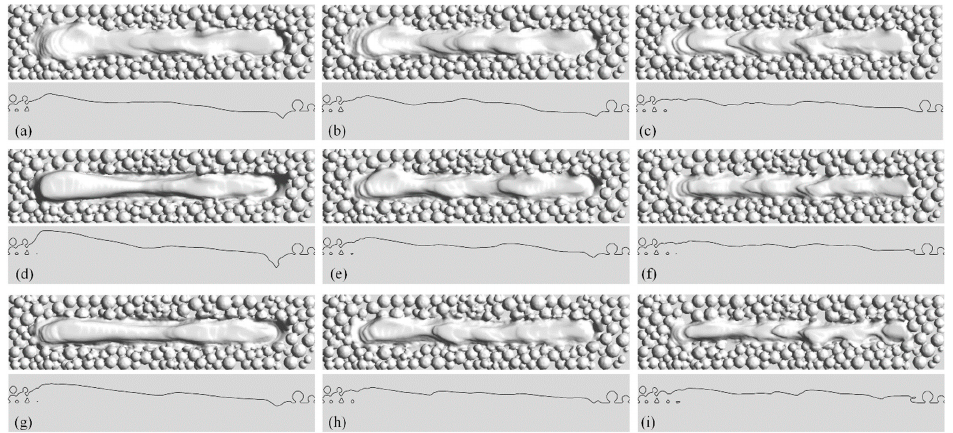
Figure 7. The morphology of the solidified track and the same on the longitudinal section under different laser powers and scanning speeds. ( a ) 200 W, 1 m/s; ( b ) 150 W, 1 m/s; ( c ) 100 W, 1 m/s; ( d ) 200 W, 1.5 m/s; ( e ) 150 W, 1.5 m/s; ( f ) 100 W, 1.5 m/s; ( g ) 200 W, 2 m/s; ( h ) 150 W, 2 m/s; ( i ) 100 W, 2 m/s.